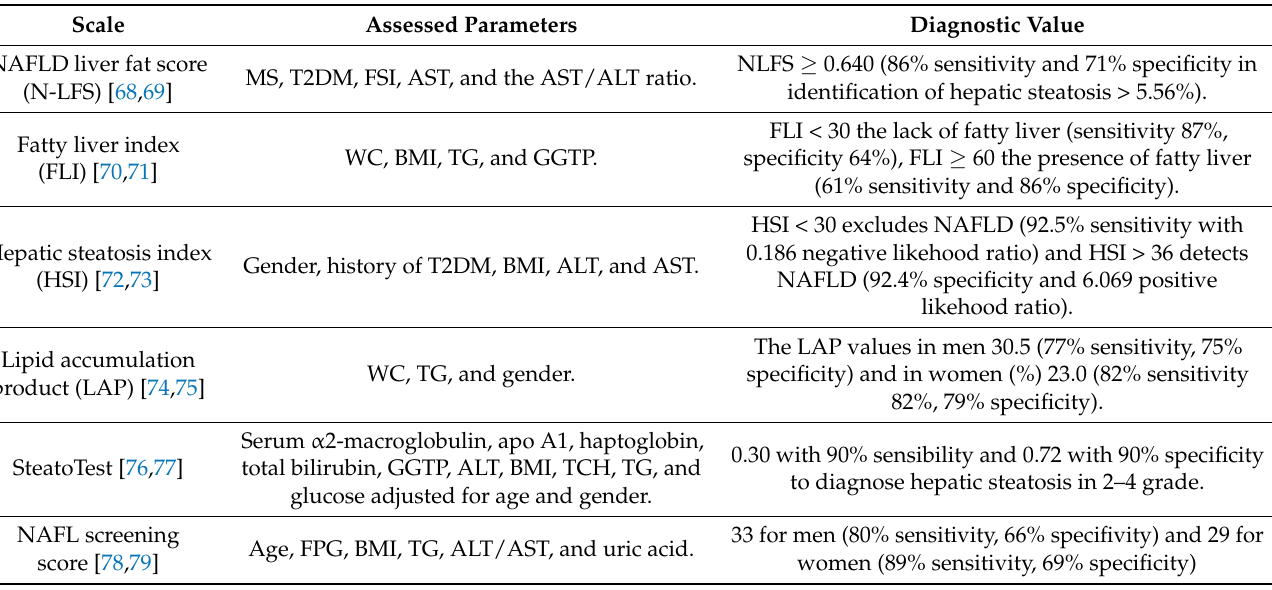
Table 1. NAFLD diagnostic